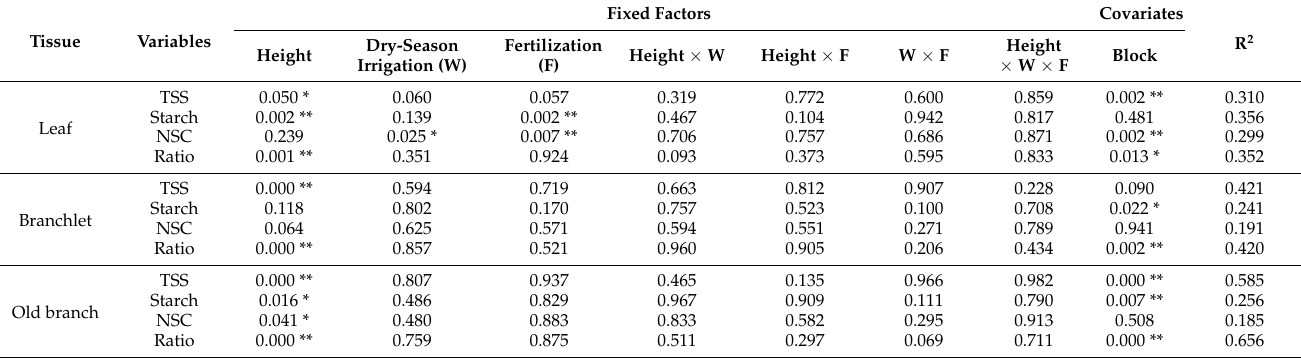
Figure 3. Changes in TSS, starch, NSC concentration and ratio of TSS to starch in the stem of E. urophylla × E. grandis under different treatments. The average value and standard error of each time are shown ( n = 5). The ( a , b ) represent the stem xylem and stem cambium. Numbers 1–4 indicate the concentrations of TSS, starch, NSC and the ratio of TSS to starch, respectively. The letters over the bars represent the results of Duncan’s multiple comparison analysis. Different capital letters indicate significant differences between different tree heights under the same treatment ( p < 0.05). Different lower-case letters indicate significant differences between different treatments for the same tissues ( p < 0.05). Table 3. The multivariate general linear model (MGLM) of the aboveground NSC concentrations with treatment, height, and